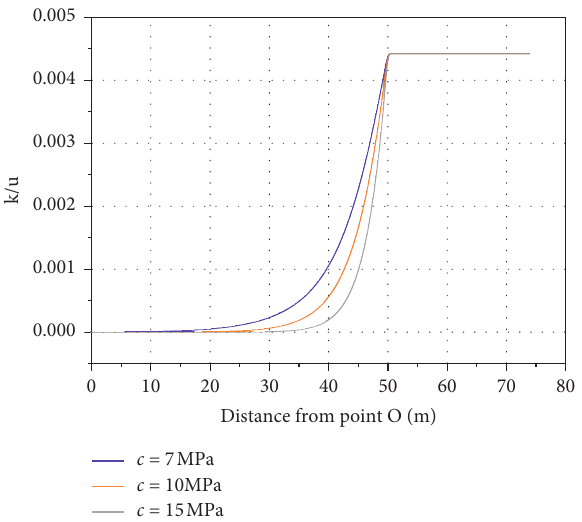
Figure 6: Change curves of the value of k/ u in different c